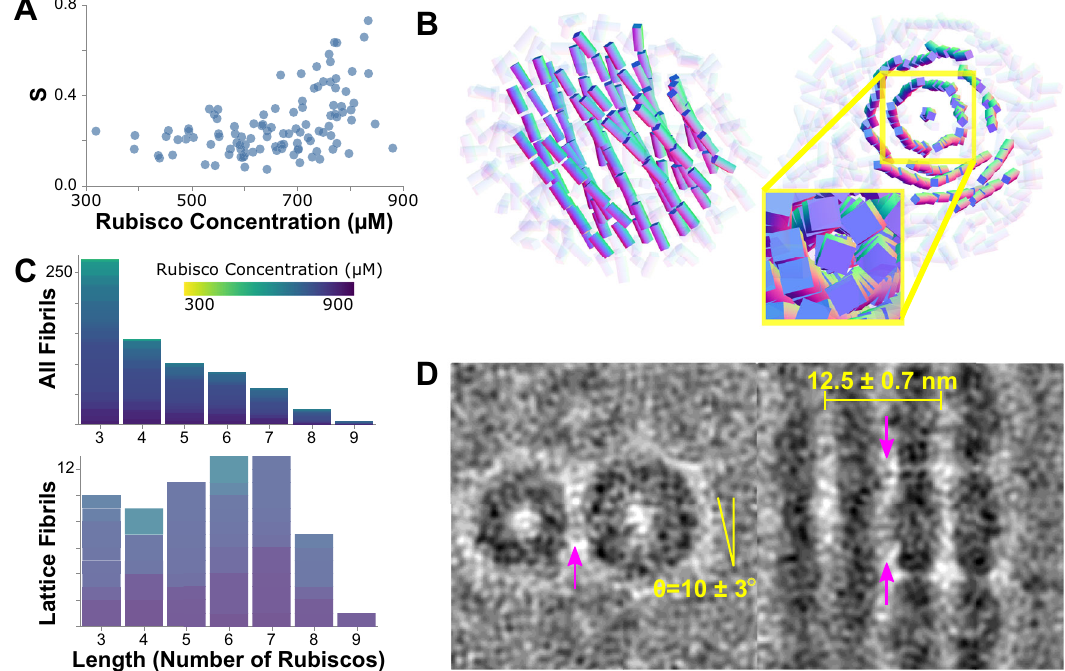
C Histograms of fi bril length for all fi brils (upper) and inner-lattice fi brils (lower) show that lattice formation is associated with increased fi bril length. D Subtomogram averages show loose registration between the fi brils, with con- sistent spacing and tilt. Faint density in the fi bril interface (magenta arrows) does not average to a speci fi c interaction